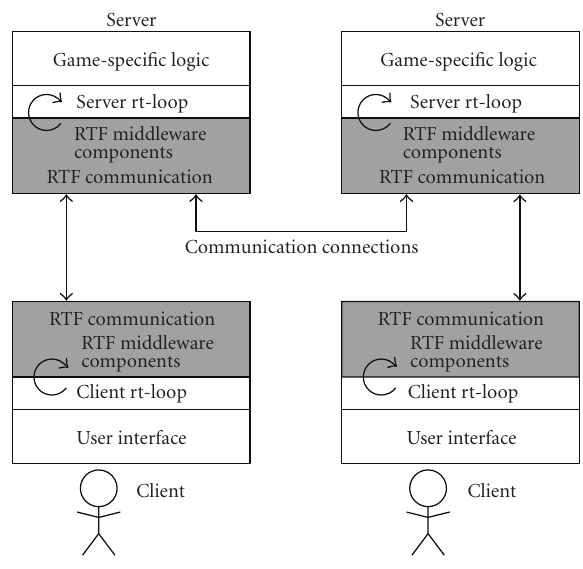
Figure 4: RTF multiserver